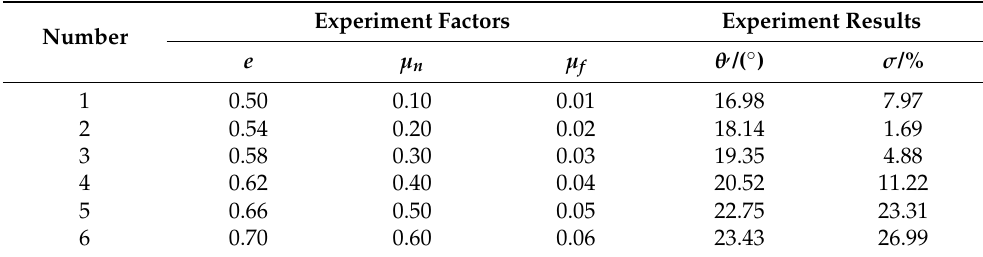
Table 11. Design and results of the steepest ascent